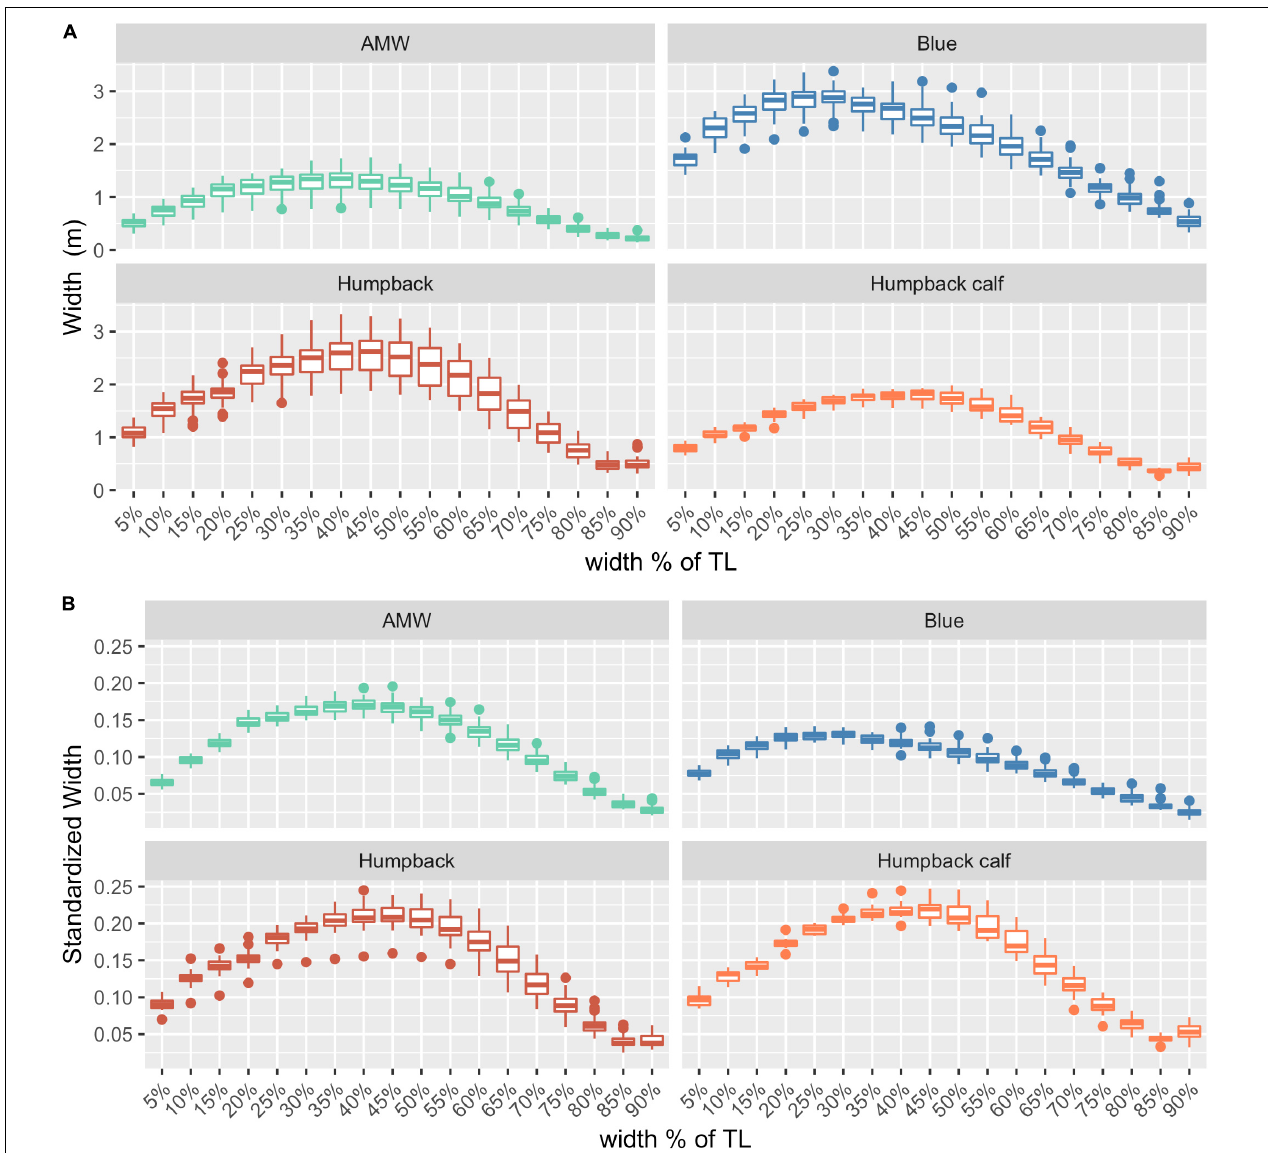
FIGURE 2 | Body shapes for each species. (A) Absolute widths (m), (B) relative widths, standardized by dividing each width by the total length of the individual. AMW, Antarctic minke whale ( n = 40), blue whales ( n = 32), humpback ( n = 40), and humpback calves ( n = 15). The middle line in each box represents the median, or second quartile (50th percentile), the lower and upper hinge of the box represent the first and third quartile (the 25th and 75th percentile), respectively, and the lower and upper whisker represents the smallest and largest value that extend at most 1.5 × IQR, where IQR is the interquartile range. Any data beyond these whiskers are considered outlying points and plotted